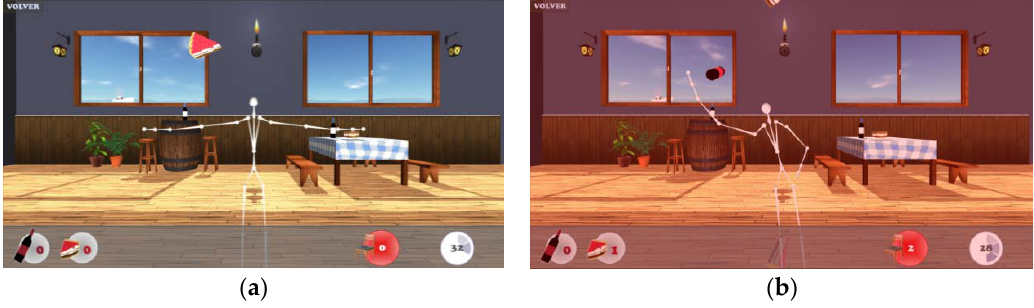
Figure 3. ( a ) Screen of a user playing correctly; ( b ) Screenshot of an error while playing